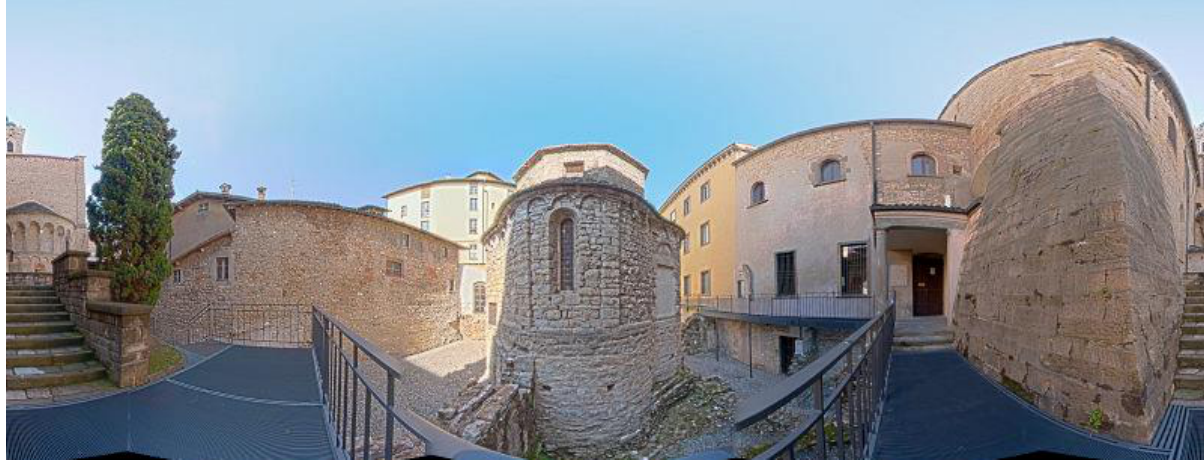
Figure 1. A spherical image of the St. Croce church in